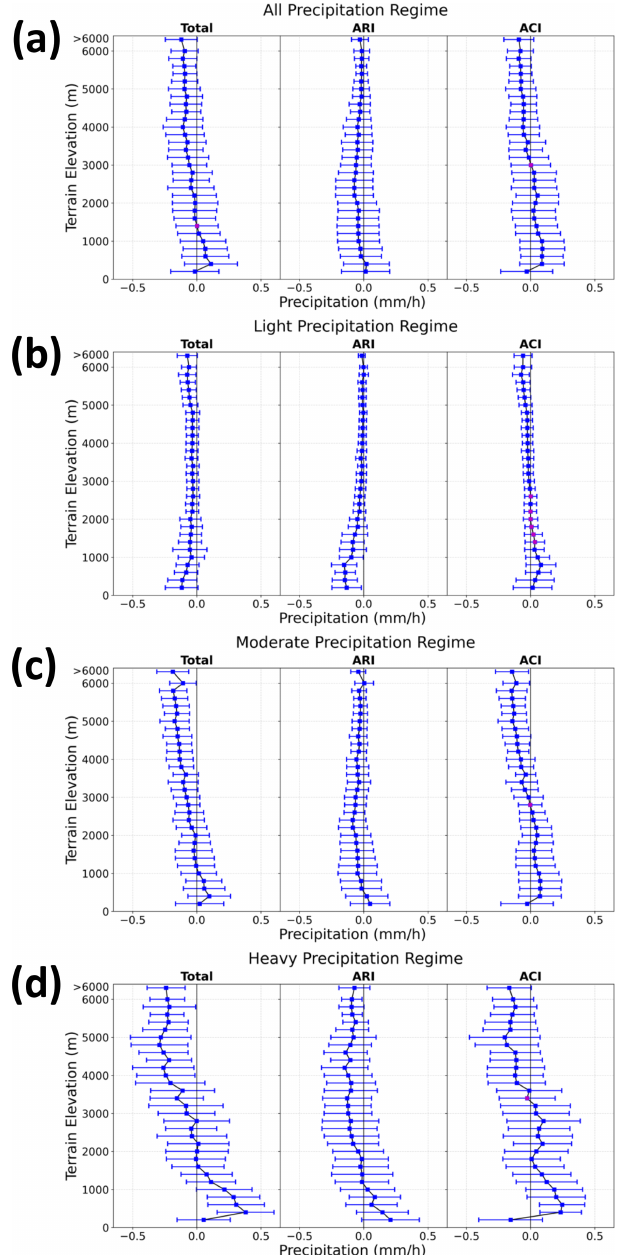
Figure 9. Elevational variability in different regime – (a) all, (b) light, (c) moderate, and (d) heavy – precipitation differences due to aerosols. The blue dots and error bars represent the mean and ± 1 standard deviation. The pink dot indicates that the differ- ences between the two simulations are not significant at the 90% confidence interval based on the Student t